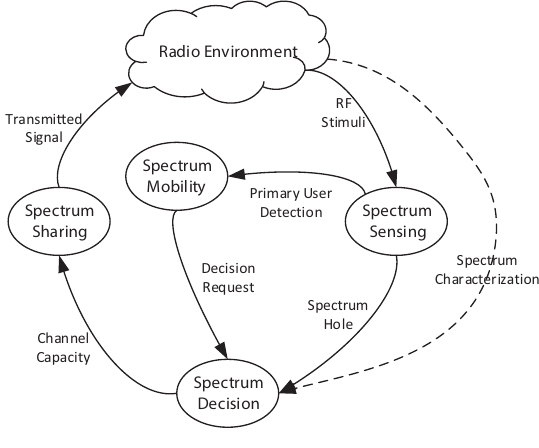
Figure 1. The cognitive